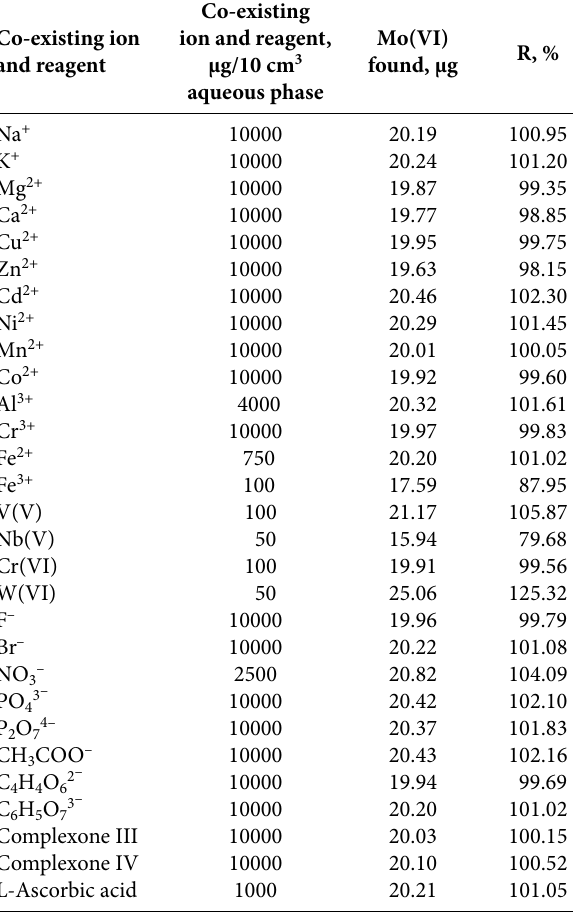
Table 2. Effect of co-existing ions and reagents on the complex for- mation of the ion-associate Mо(VI)–3,5-DNC–TTC for extraction in the presence of 20 μg Mo(VI)